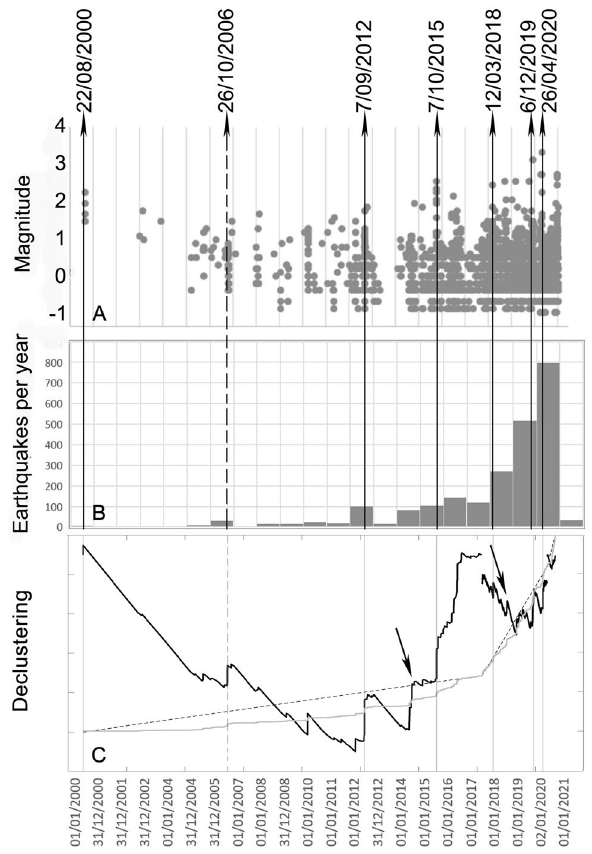
Figure 1. Earthquakes magnitudes ( A ) and annual occurrence ( B ) recorded in the Campi Flegrei caldera from January 2000 to March 2021. Vertical rows indicate the 6 main swarms analyzed in this article and the main LP swarm (dashed) recorded by the seismic network of Osservatorio Vesuviano, INGV. ( C ) The declustering functions in normalized units (black bolds lines) compared with the cumulative number (grey line) and the expected number of earthquakes based on the estimated rate (dashed